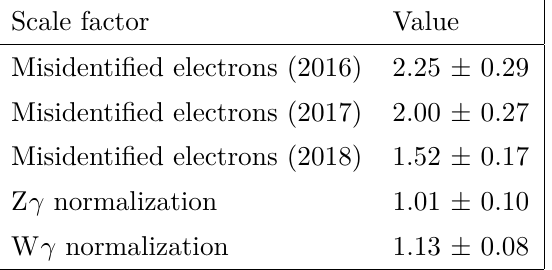
Table 4 . Extracted SFs and the total uncertainty obtained from the likelihood fit for the contri- bution from misidentified electrons for the three data-taking periods, and for the normalization of the Z γ and W γ background